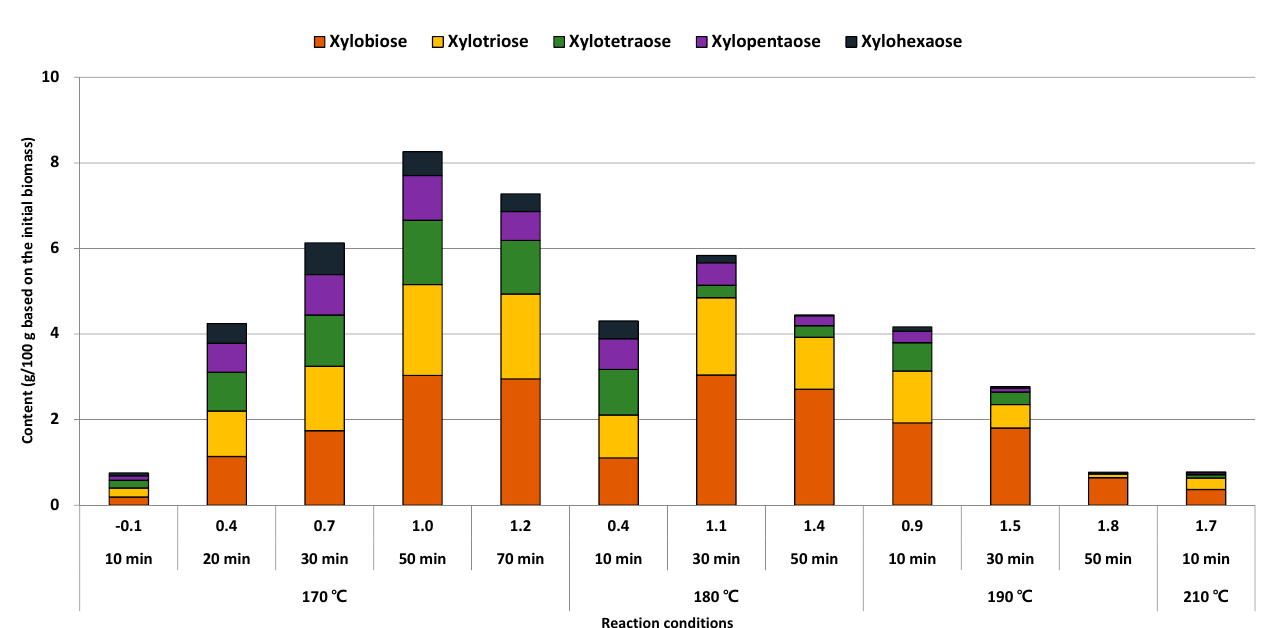
Figure 3. Xylose and XOS content (g/100 g initial biomass) of liquid hydrolysate after LHW treatment from E. pellita . This trend of the total XOS content at 170 °C conditions was changed at 180 °C conditions. As reaction time extended from 30 min to 50 min, total XOS content decreased from 5.8% to 4.5%. A declining trend of total XOS content continued steadily at 190 °C as an increase of reaction time, and the total XOS content was observed as 0.8% at 210 °C for